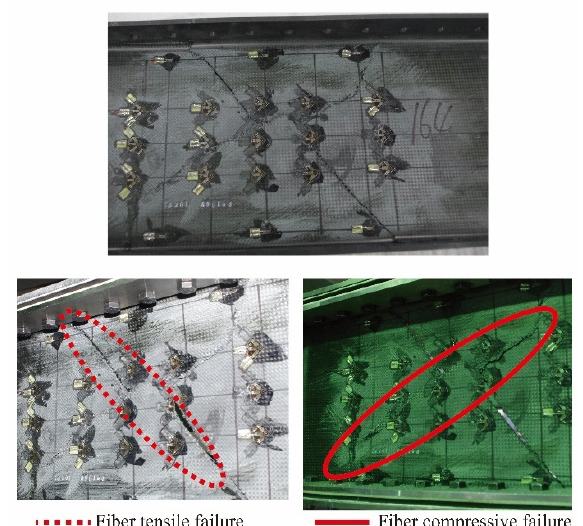
Figure 8. The failure state of the BW-I-01 composite beam after the collapse under shear load.